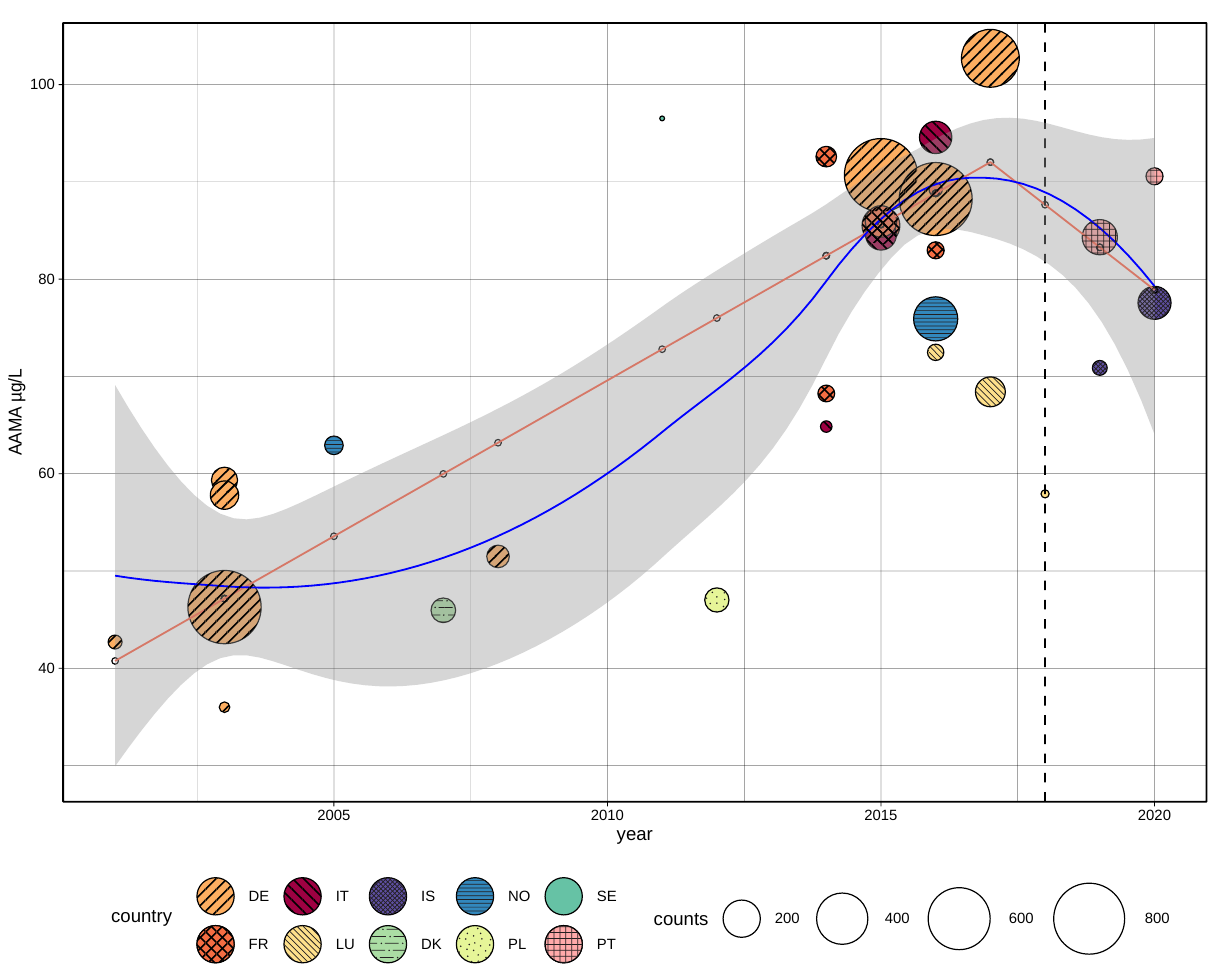
Figure 5. Locally fitted scatter-plot fit (LOESS) for AAMA time-trend data (harmonized, non-smokers). Study means represented by country color-coded dots with size dependent on count number and 95%-confidence interval (gray). LOESS fit line in blue. The red line shows the trend of a multi- segmented regression analysis (significant break-point detected in 2017, p < 0.001). Dashed line indicating the time-point of Commission Regulation 2017/2158 put in force